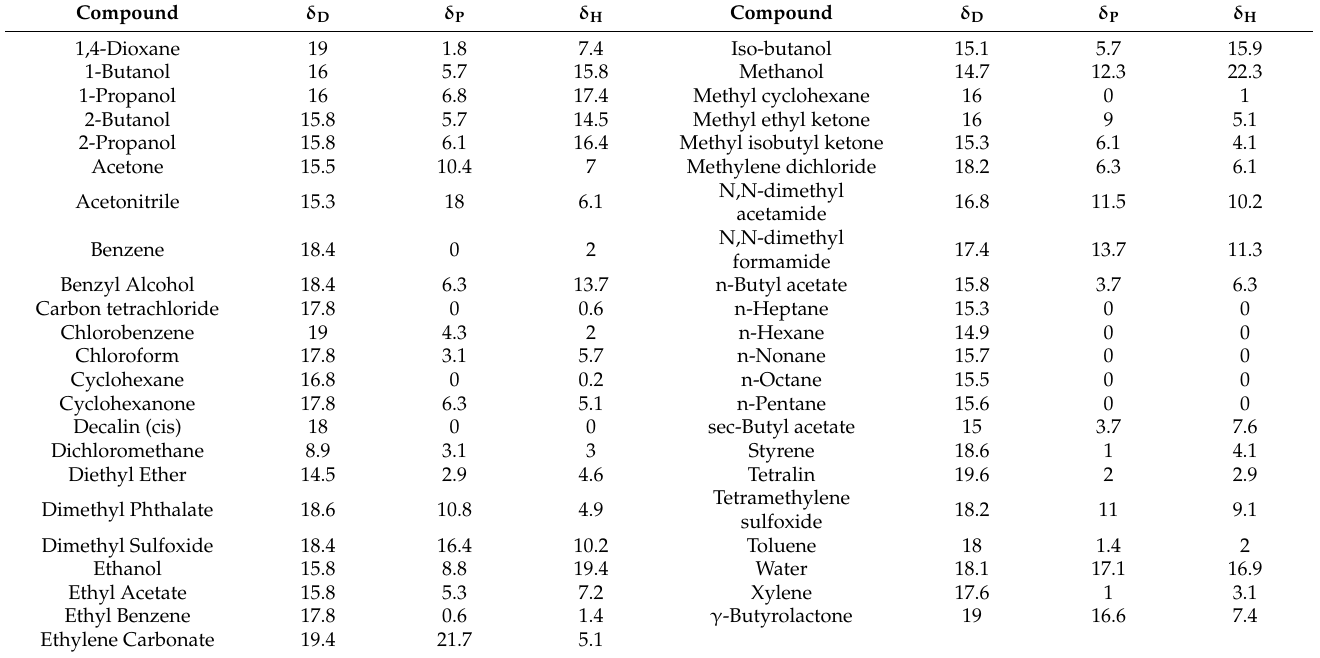
Tables 10 ad 11 consolidate HSP for common solvents and solutes. Table 10. HSP values of solvents as described by Hansen [169].